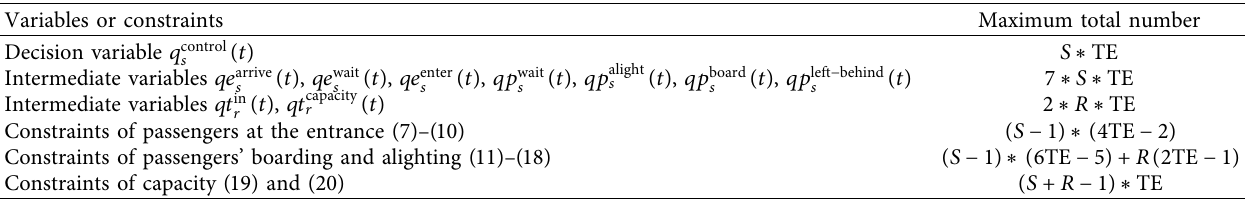
Table 3: Scale of variables and constraints in the